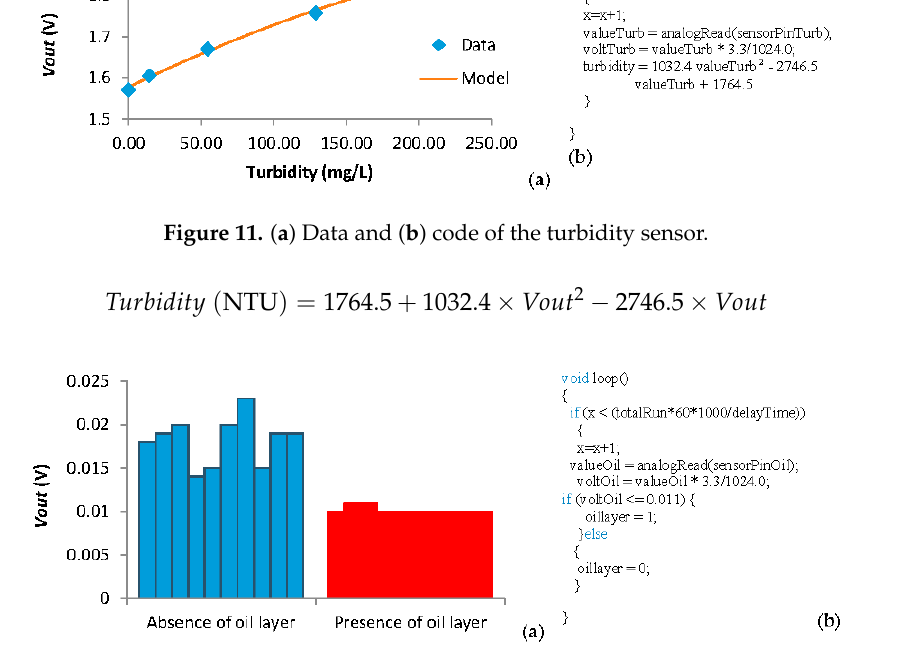
Figure 10. ( a ) Data and ( b ) code of the temperature sensor.